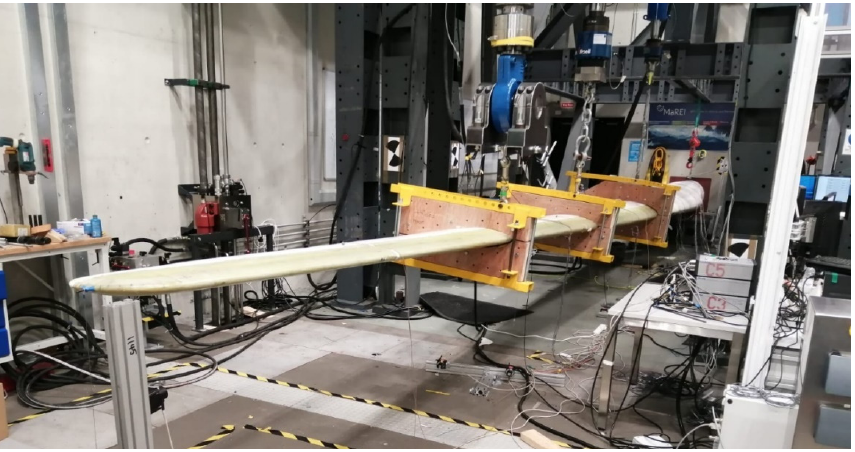
Figure 5. Wind turbine blade undergoing static testing in the flapwise direction using a multi-actuator load introduction system.